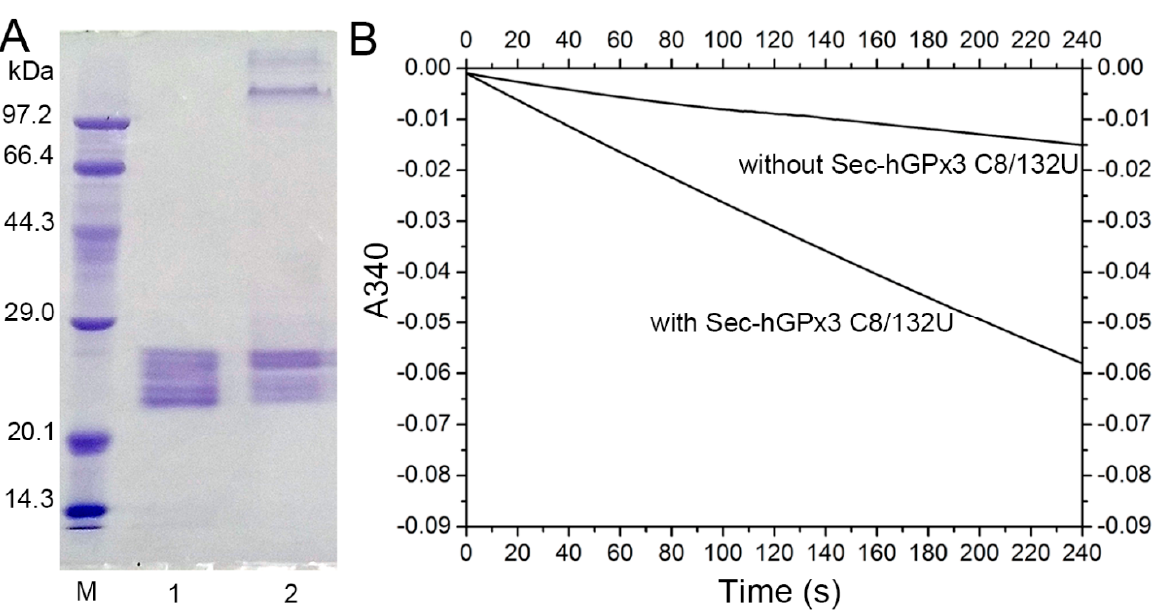
Figure 7. Effects of ( A ) temperature and ( B ) PH on the activity of Sec − hGPx3 − C8/132U: Activity was determined with the concentrations of GSH and t − BuOOH at 1 mM and 0.3 mM, respectively. ( A ) Plot of GPx activity versus temperature; the highest activity at 50 °C was set as 100%; ( B ) Plot of GPx activity versus pH; the highest activity at pH 10 was set as 100%.